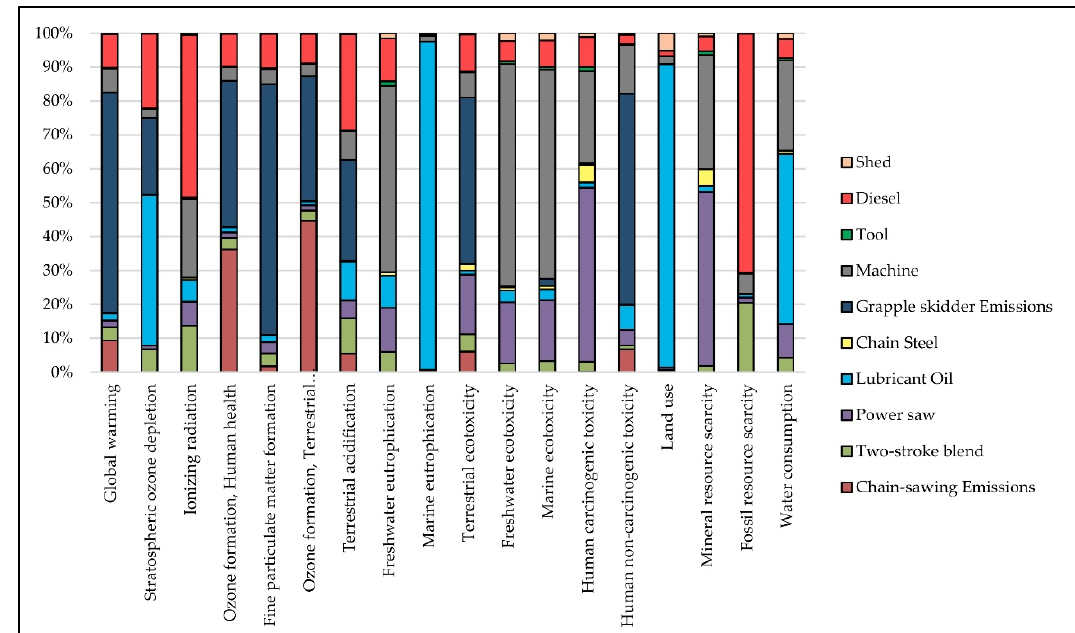
Figure 9. Contribution analysis related to scenario (ii), grapple skidder.